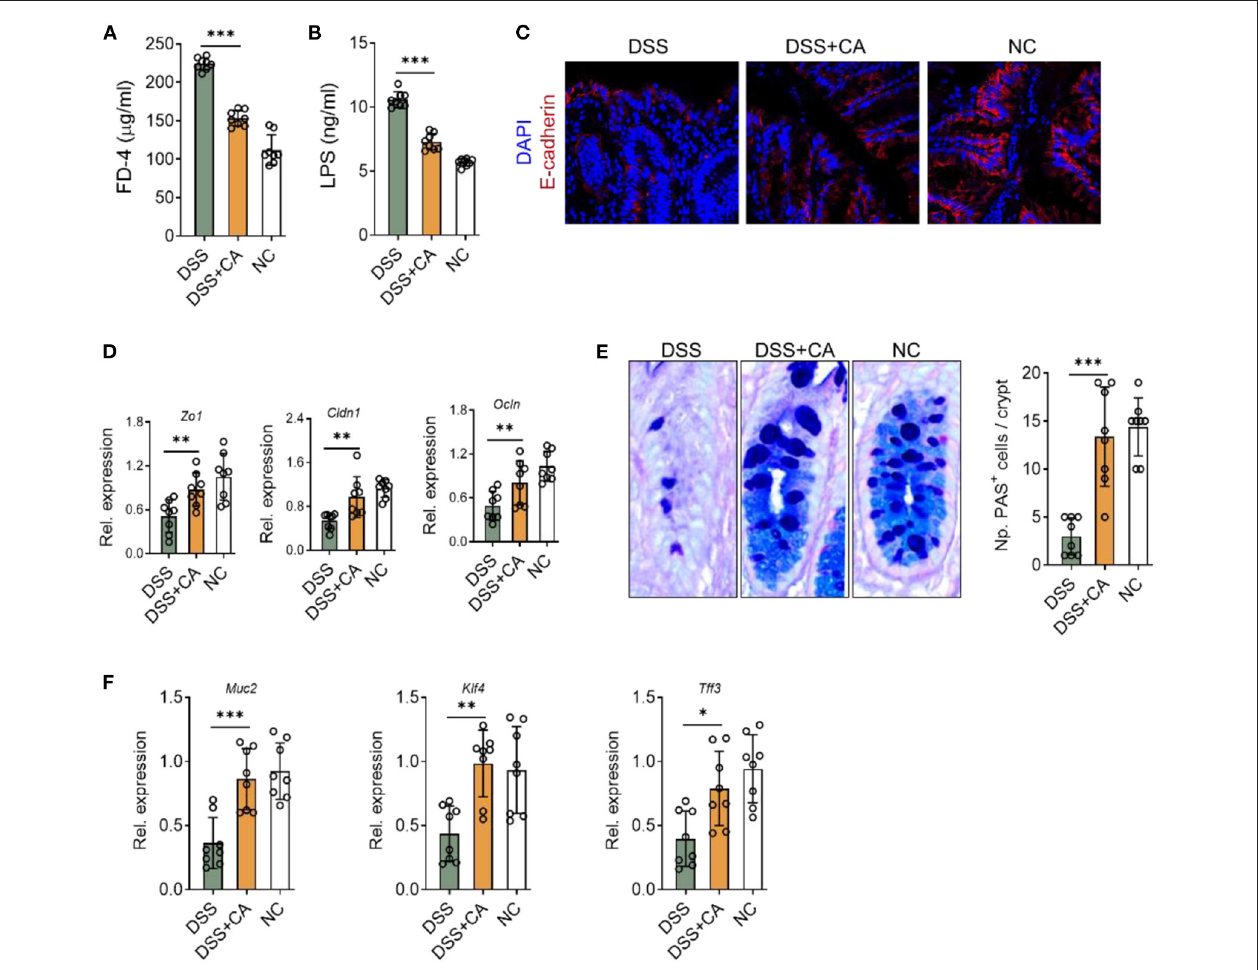
FIGURE 4 | CA restores epithelial barrier functions in intestinal inflammation. Colitis was induced as described in Figure 1 . (A , B) Intestinal permeability in all three groups was assessed on day 10. (A) Serum FD-4 levels were measured 4h after oral gavage of FD-4. (B) Levels of serum lipopolysaccharides (LPS) were measured. (C) Colonic sections were stained for E-cadherin and DAPI. Representative immunofluorescence images are shown. (D) Expression levels of colonic ZO-1, claudin-1, and occludin in all three groups by qRT-PCR. (E) Colonic goblet cells were identified by PAS staining. Representative images are shown (left) and the number of goblet cells was quantified. (F) The expression of colonic MUC2, KLF4, and TFF3 were detected by qRT-PCR. Data are presented as mean ± SD. Representative data of three independent experiments are shown. One-way analysis of variance (ANOVA) followed by Tukey’s multiple comparisons test, * p < 0.05, ** p < 0.01, and *** p <